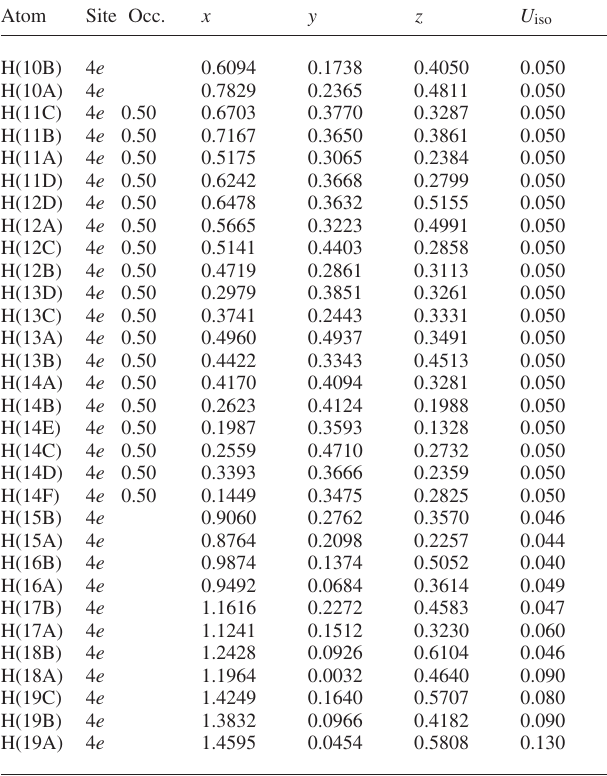
Table 2. Atomic coordinates and displacement parameters (in Å 2 )